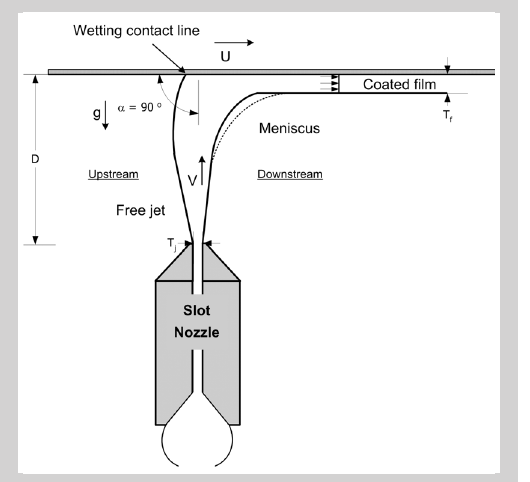
Figure 1: Magnification of application